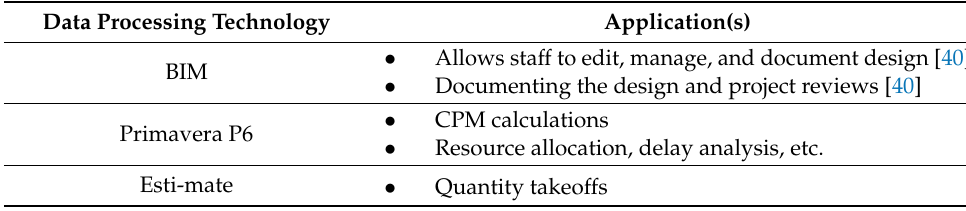
Table 2. Examples of applications of data processing